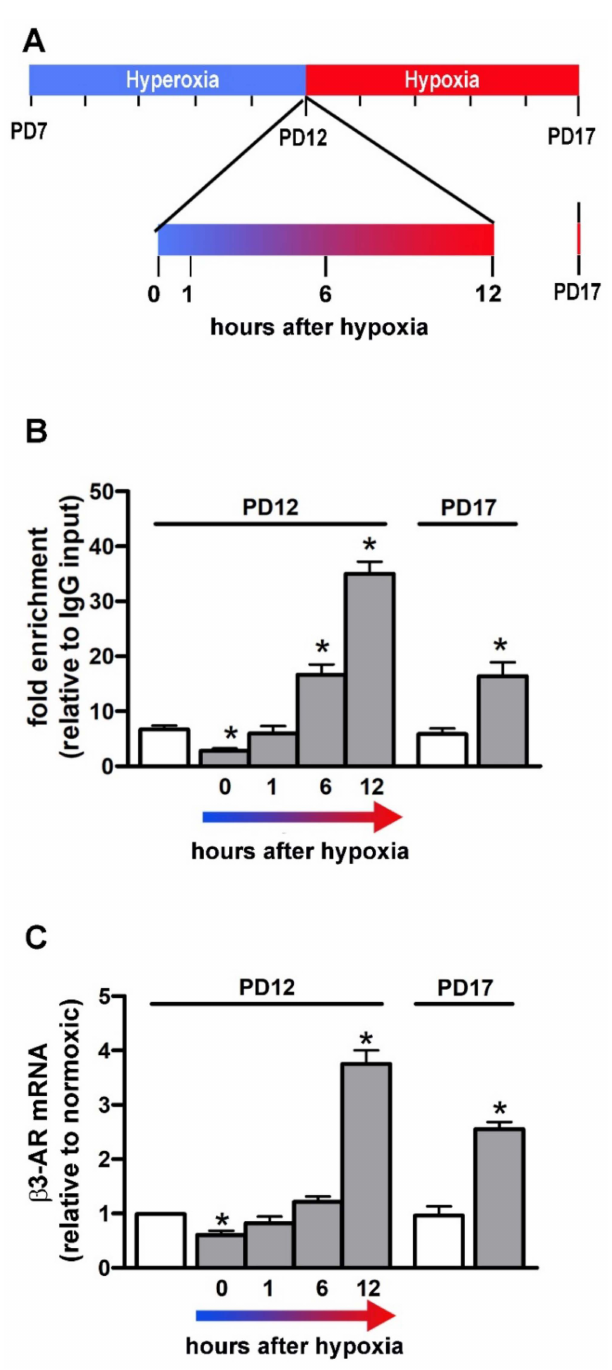
Figure 7. HIF-1 α interaction with HBS #1 and corresponding β 3-AR gene expression at PD12 (from 0 to 12 h of hypoxia) or at PD17. ( A ) Schematic diagram of the OIR model pointing to the specific times under analysis. ( B ) Data from HIF-1 α chromatin immunoprecipitation and HBS #1-specific qPCR (ChIP-qPCR) represented as fold enrichment relative to IgG input. ( C ) Corresponding levels of β 3-AR mRNA. White bars represent data from retinas of normoxic controls while grey bars represent data from hypoxic mice. One-way ANOVA followed by Tukey’s multiple comparison post-hoc test. Each histogram represents the mean ± SEM of data from 6 independent samples. * p < 0.05 vs. normoxic controls ( n = 6